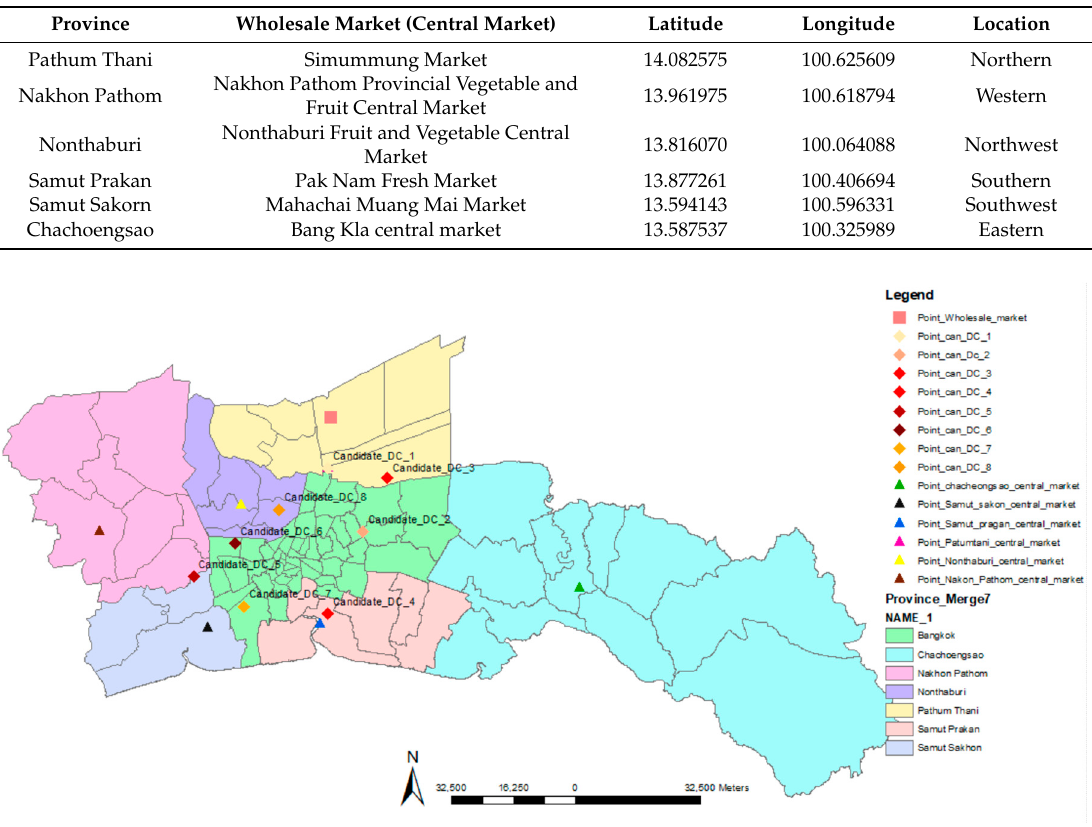
Figure 4. Locations of candidates DC and wholesale market in Figure 3. Locations of candidates DC and wholesale market in Bangkok. Table 2. Existing and candidate DC.